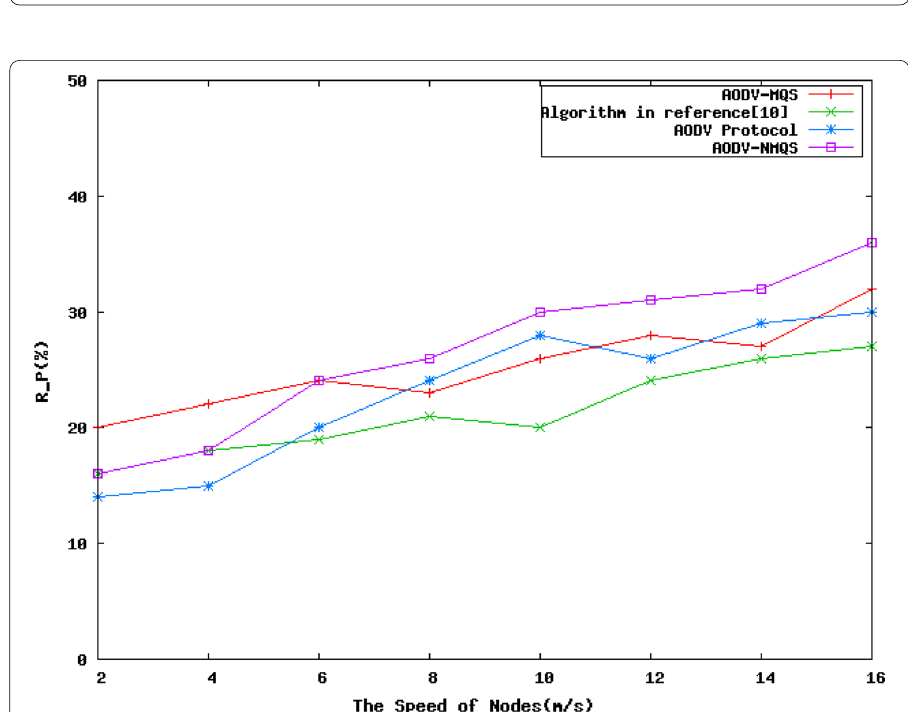
Fig. 10 Comparison of overhead of four routing algorithms in a safe